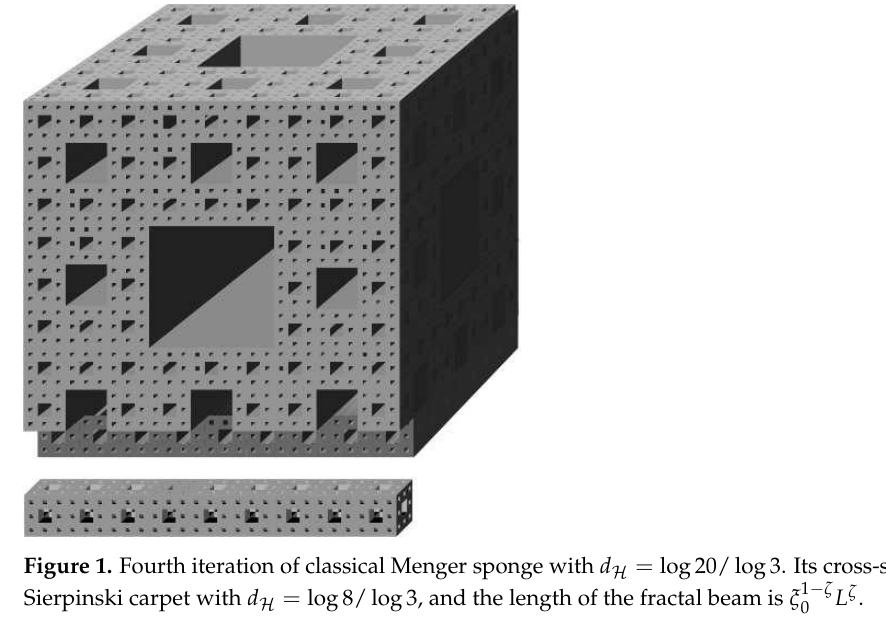
= log8/ log3, and the length of the fractal beam is ξ 1 − ζ H